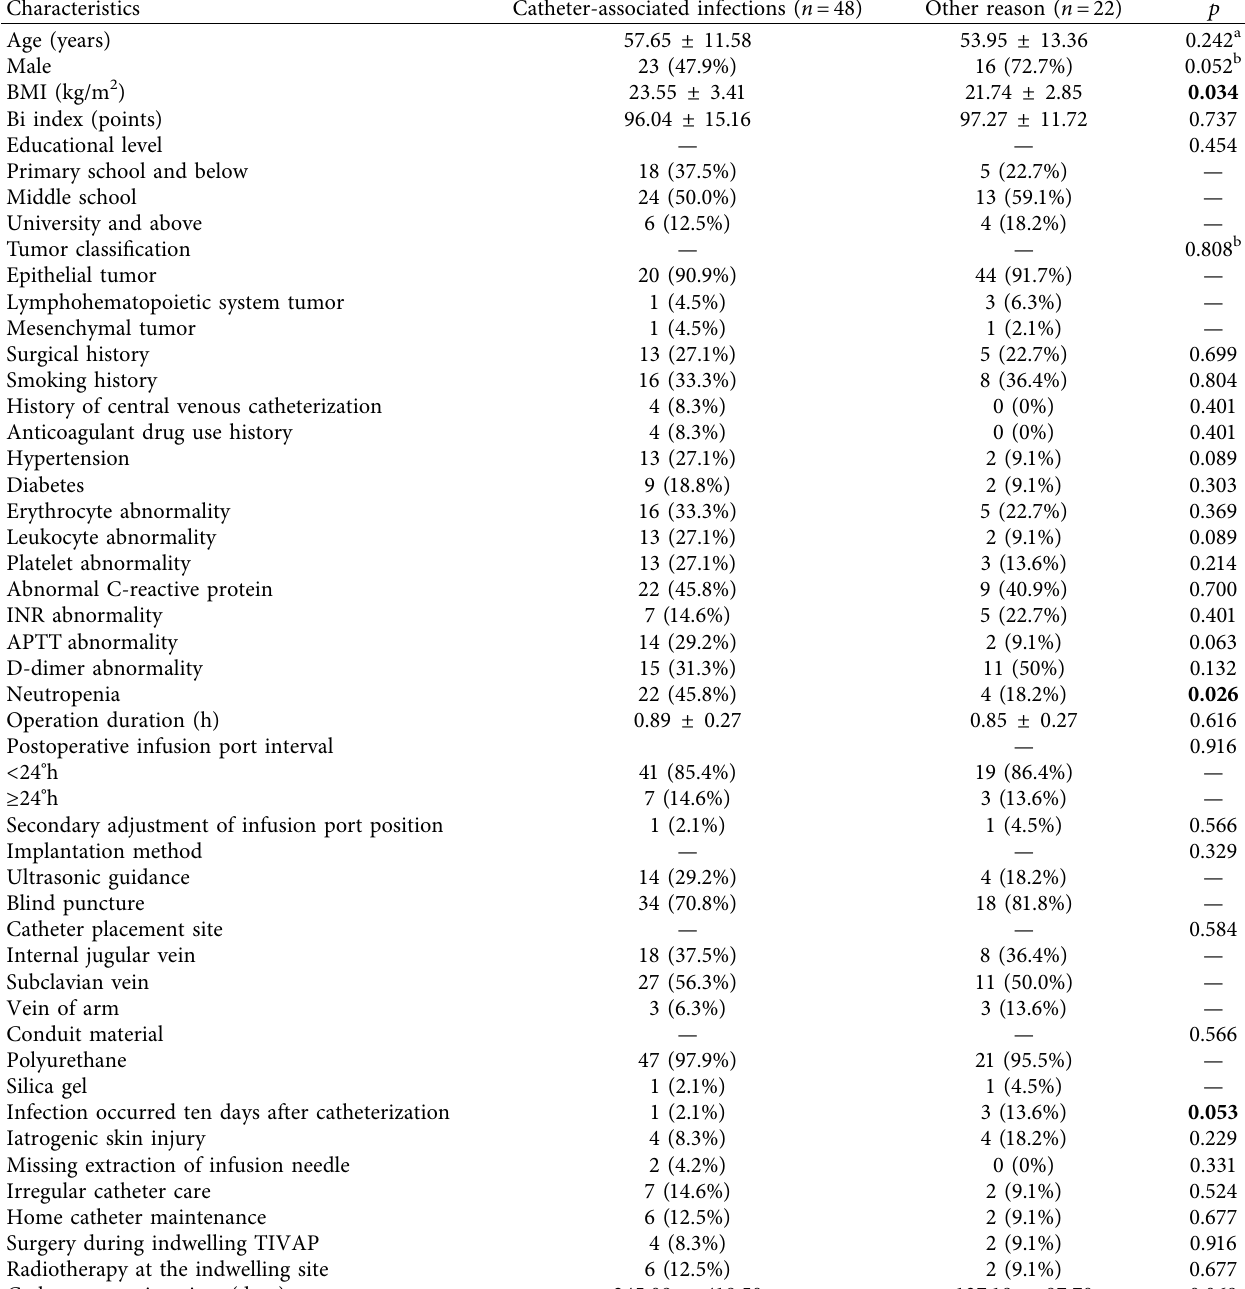
Table 1: Univariate analysis of catheter blood flow infection leading to infusion portpullout.